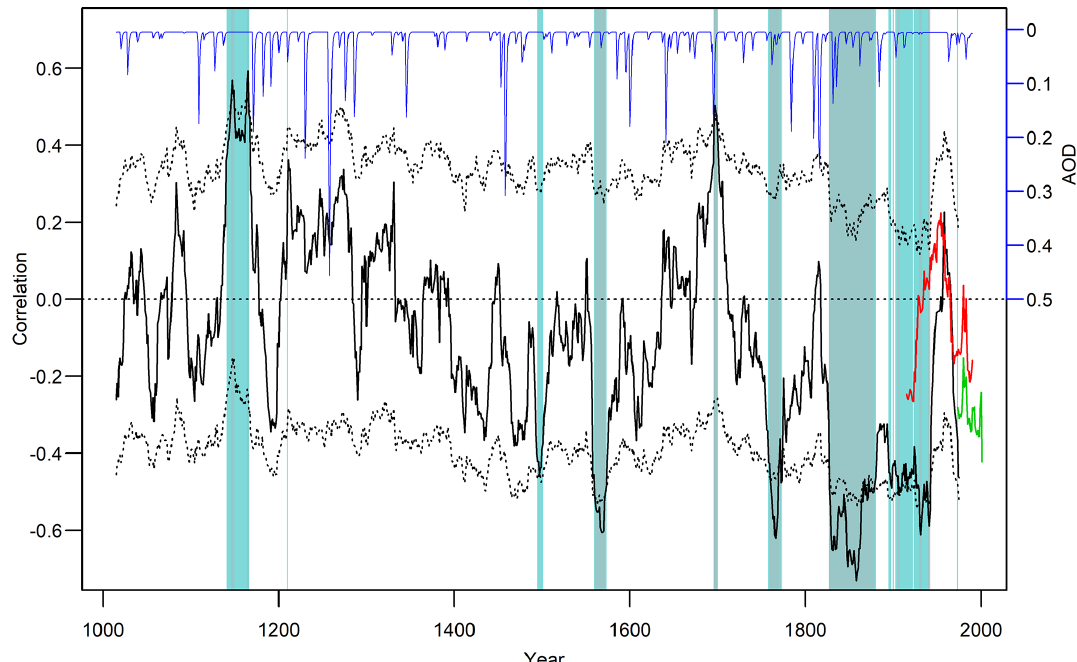
Figure 1. Thirty-one-year running correlations between real-world DJF ENSO and SAM reconstructions (black) together with 31-year running correlations of the instrumental indices (red: ENSO (Niño3.4) and Fogt SAM index; green: ENSO and Marshall SAM index). For the reconstructions, the significance of the running correlations is calculated in two different ways (see Sect. 2.2.1), and values exceeding the 95% confidence threshold are shaded with grey and cyan colour. The cyan shading corresponds to significant individual 31-year window correlations ( p < 0 . 05), taking lag 1 auto-correlation into account. The grey shading represents values that exceed the 95% confidence range (black dotted lines) obtained from the uncertainty in the reconstructions. The volcanic forcing (Toohey and Sigl, 2017) is shown in blue. Years on the x axis reflect the middle year of the 31-year running